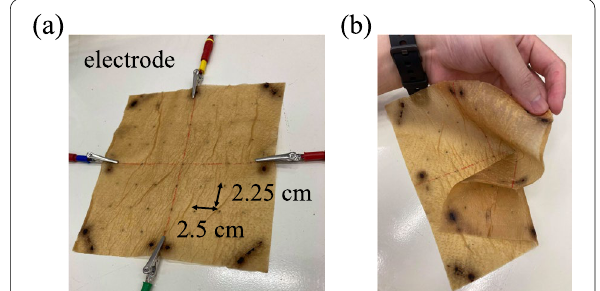
Fig. 2 a Semiconductive paper marked with 49 points at intervals of 2.5 and 2.25 cm. An electrode is attached to the center of each side of the paper (total of four electrodes). b Dry and flexible